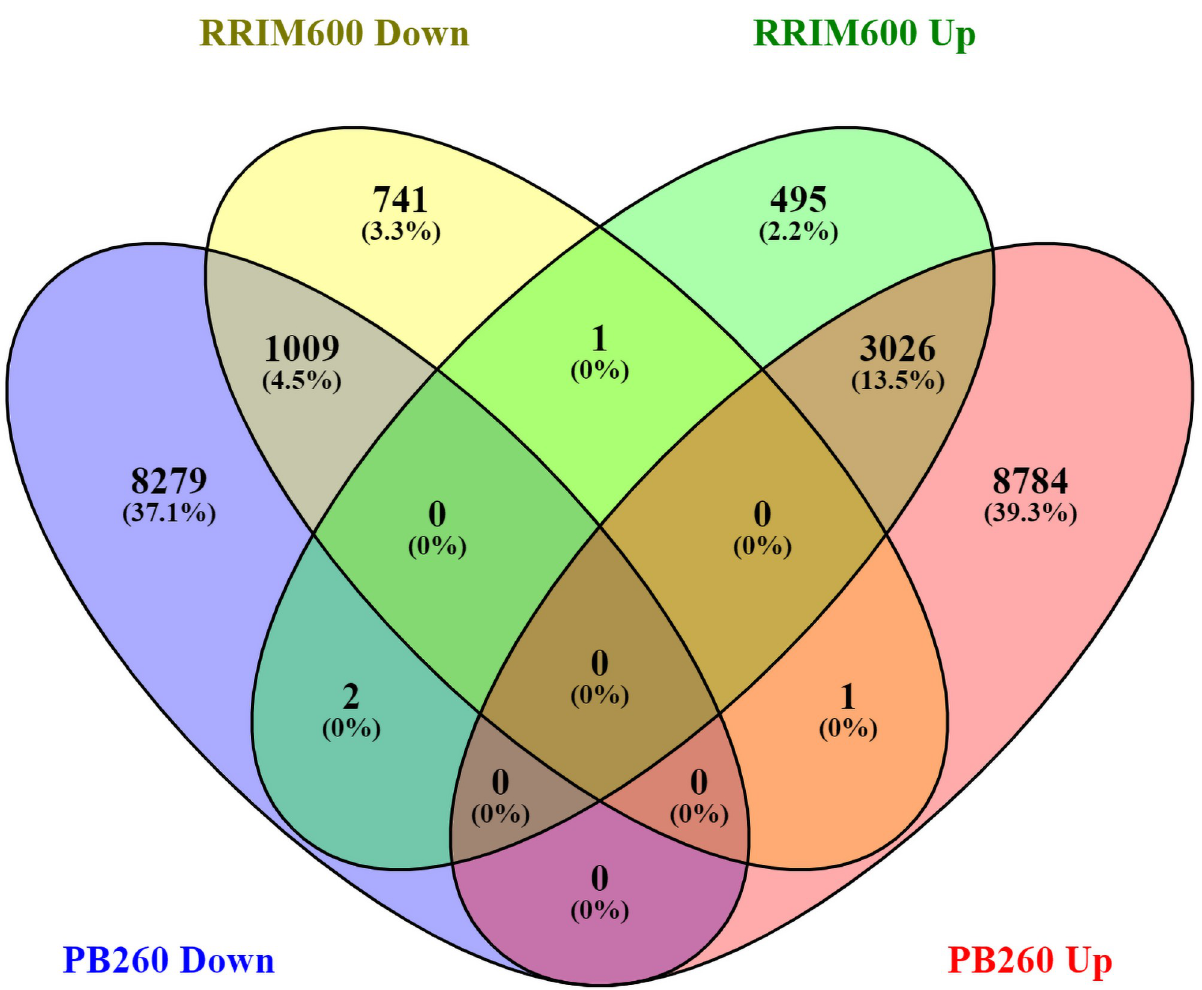
Fig 2. Venn diagram displaying the overlaps between PB260 and RRIM600 DEGs. The DEG lists were extracted from S3 Table. For this analysis, transcripts expressed at 12 hpt and 24 hpt were combined for each clone. The up-regulated (green for RRIM600 and red for PB260) and down- regulated (yellow for RRIM600 and blue for PB260) genes were counted separately. The diagram was drawn online using the VENNY tool (version 2.1).